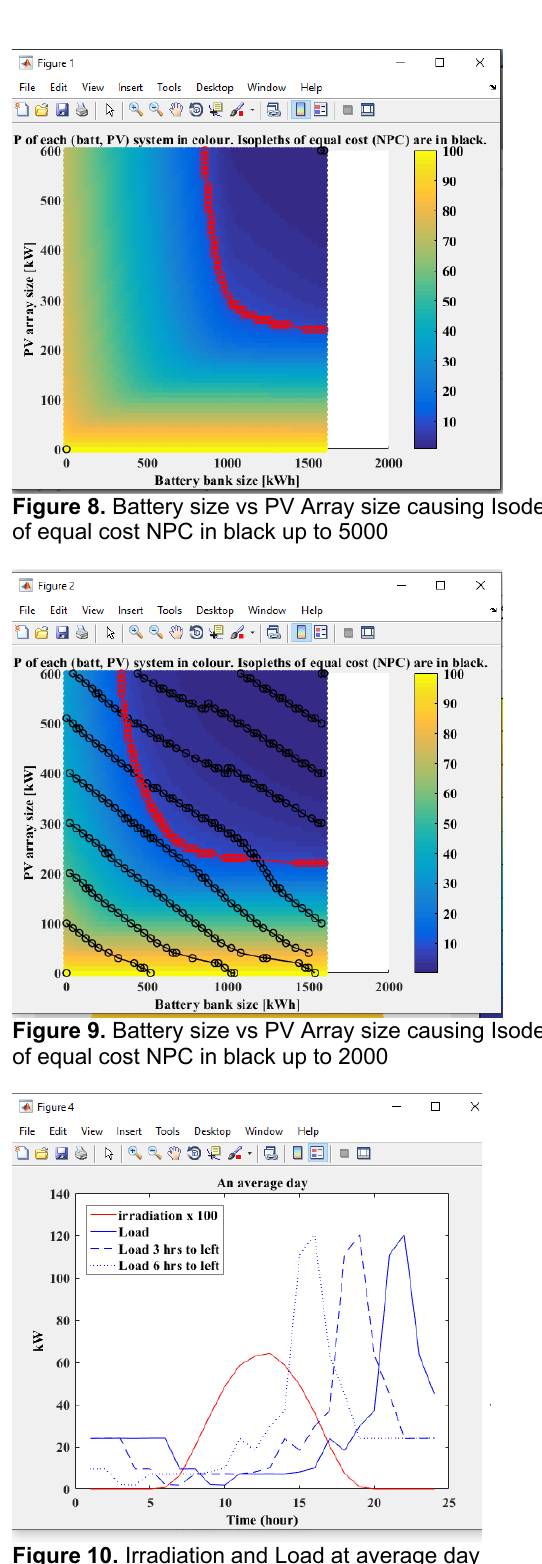
Figure 10. Irradiation and Load at average